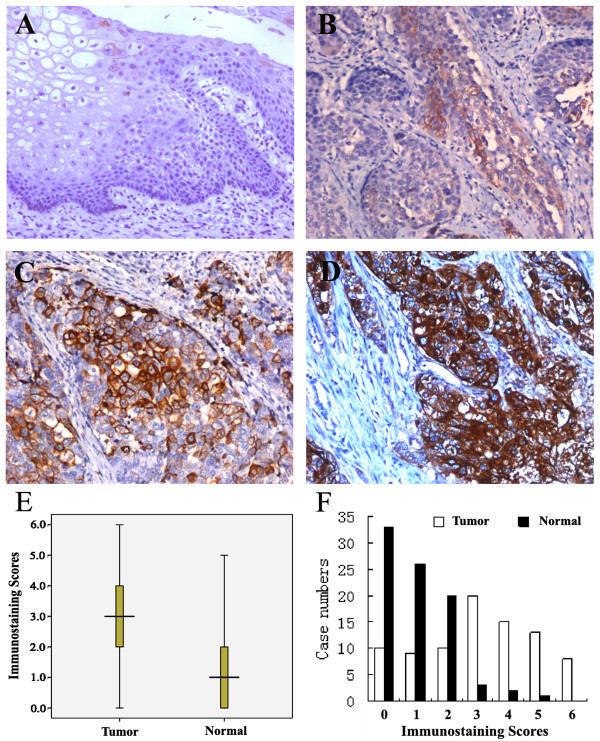
STC-1 protein expression in ESCC and matched normal tissues determined by immunohistochemical staining (magnification × 200). (A) STC-1 negative in normal tissue; (B) low STC-1 expression in tumor tissue; (C) moderate STC-1 expression in tumor tissue; (D) high STC-1 expression in tumor tissue. (E) The average immunostaining scores of STC-1 expression in tumor and normal tissues; (F) Distribution of immunostaining scores per sample in tumor and adjacent normal tissues.